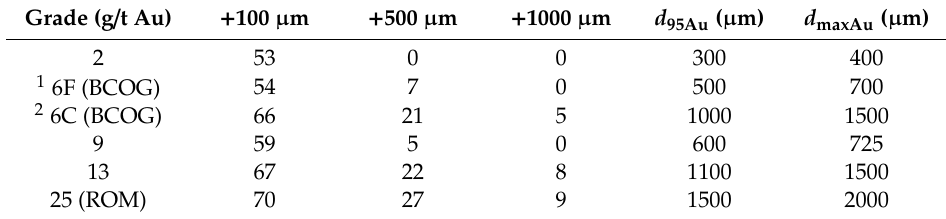
Table 15. Summary of gold particle size distribution by mass across different grades based on 18–24 t bulk sample processing.